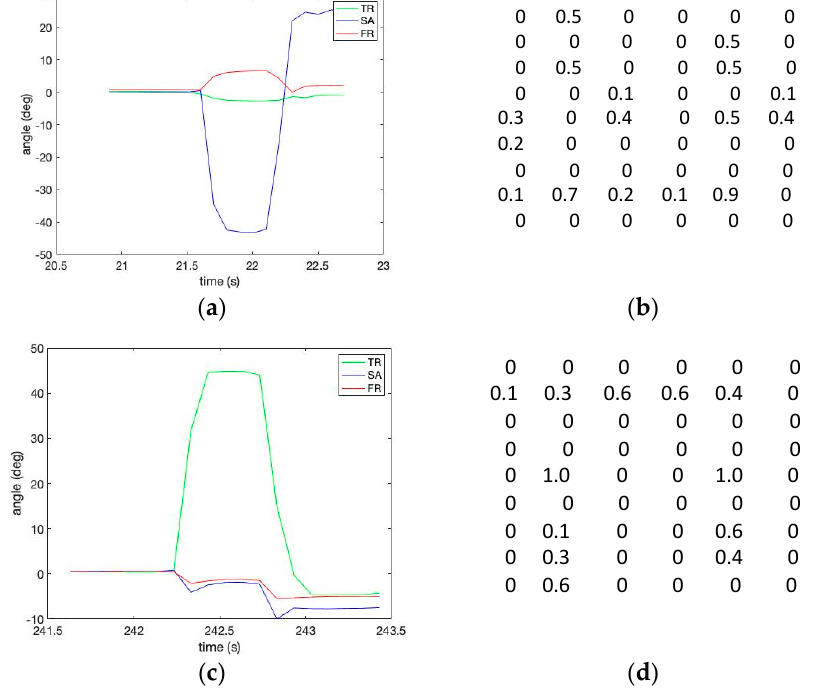
Figure 5. The template signature matrix data windows in the sensor signals: ( a ) the template angles for Experiment I—sagittal forward flexion 60°; ( b ) the template matrix for Experiment I—sagittal forward flexion 60°; ( c ) the template angles for Experiment II—transverse right rotation 50°; ( d ) the template matrix for Experiment II—transverse right rotation 50°.